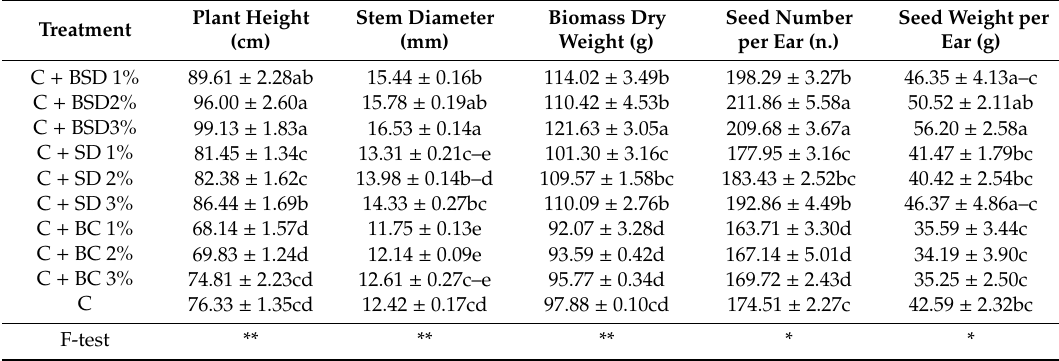
Table 3. E ff ects of soil amendments on vegetative parameters in maize cultivation ± standard error. Plant Height Stem Diameter Biomass Dry Seed Number Seed Weight per Treatment (cm) (mm) Weight (g) per Ear (n.) Ear